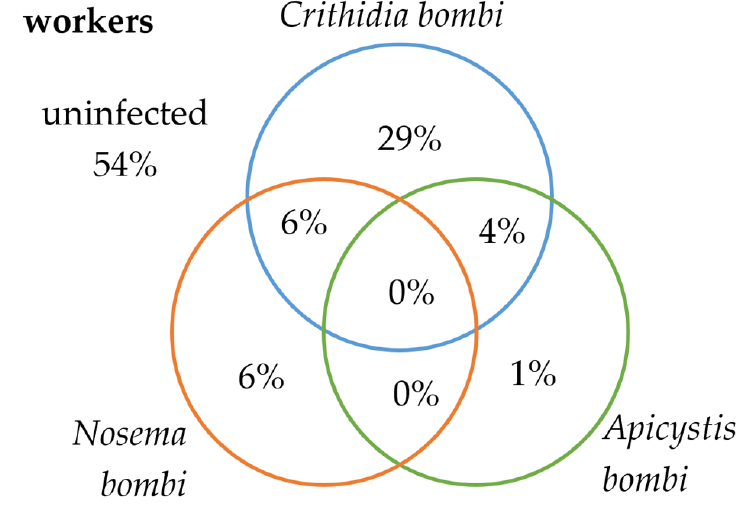
Figure 6. Percentage of individual PCR-positive B. lapidarius specimens individually and simultaneously infected with the pathogens C. bombi , A. bombi and N. bombi for workers.